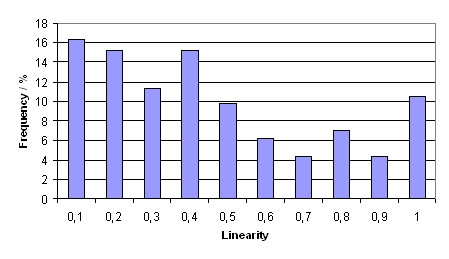
3-point linearity.